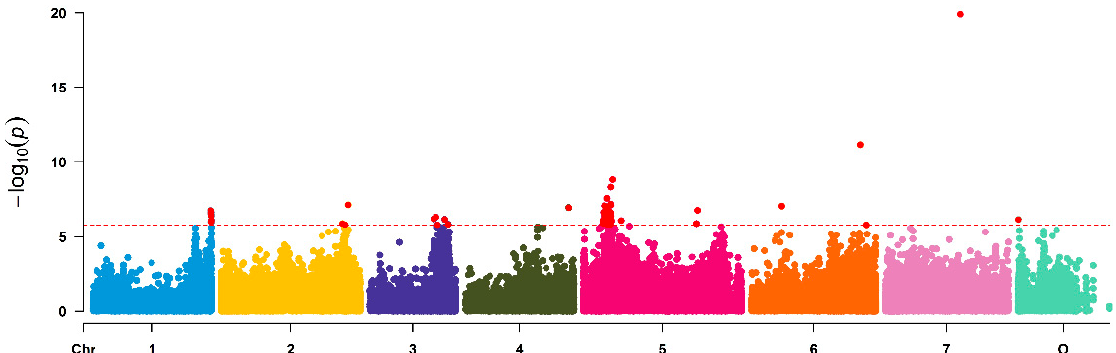
Figure 5. Manhattan plot of associations between 63,000 SNP markers and petal length in a set of 95 garden roses. The x -axis represents the chromosomes of Rosa chinensis , including chromosome 0 with contigs not assigned to a precise location to date. Associations were calculated in Tassel 3.0 using MLM including population structure (Q) and kinship (K) and Box-Cox transformed data of fragrance. The red dotted line indicates the Bonferroni corrected level of significance ( − log10 = 5.75).